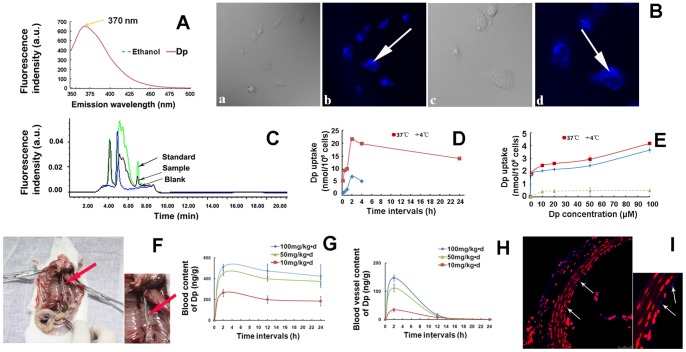
Determination of Dp uptake by VECs.(A) The autofluorescent emission spectra of Dp and ethanol (baseline). The peak emission wavelength was recorded at approximately 370 nm. (B) HUVECs were treated with 10 μM Dp for 2 h and the subcellular Dp distribution was measured using a CLSM (b, ×400 and d, ×1000 magnification) and with a contrast phase microscope (a, ×400 and c,×1000 magnification). (C) Evaluation of intracellular Dp content in HUVECs via HPLC. After incubation, cells were lysed and the supernatant was collected for HPLC analysis. The blank control cells was treated with 0.1% DMSO. The excitation spectra of the fluorescence for λem  = 370 nm is presented in arbitrary units (a.u.). (D-E) Time, dos-, and temperature-dependent uptake of Dp in HUVECs was measured via HPLC. (D) HUVECs were treated with 10 μM Dp at 37 (▪) and 4°C (⧫) for the indicated times (10 min, 30 min, 1 h, 2 h, 4 h, and 24 h, respectively). (E) HUVECs were treated with different Dp concentrations (1, 10, 20, 50, and 100 μM, respectively) for 2 h at 37°C (▪) or 4°C (⧫), respectively. The difference between incorporated Dp by HUVECs at 37°C and that at 4°C represents the actively transported amount (▴). BABL/c mice were intravenously administrated different Dp doses or an equivalent volume of hydro-alcoholic solution. (F) Representative image showed the isolated thoracic aorta (red arrow). The Dp content in the blood (G) and isolated thoracic aorta (H) were measured by HPLC. The isolated thoracic aortas were separated, frozen sectioned, and then stained with PI to visualize the nuclei. (I) Representative fluorescent signals (white arrows) of Dp in blood vessels were observed by by CLSM (TCS SP2, Leica Microsystems GmbH). Values are presented as means ± SEM, n = 3.